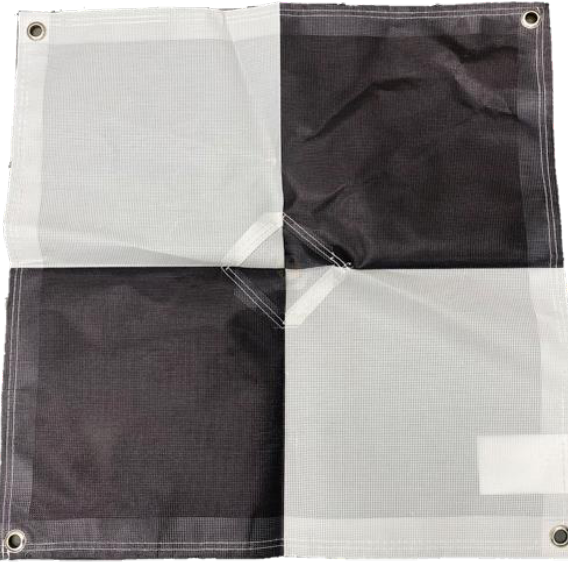
Figure 4. Checkerboard. Figure 4.